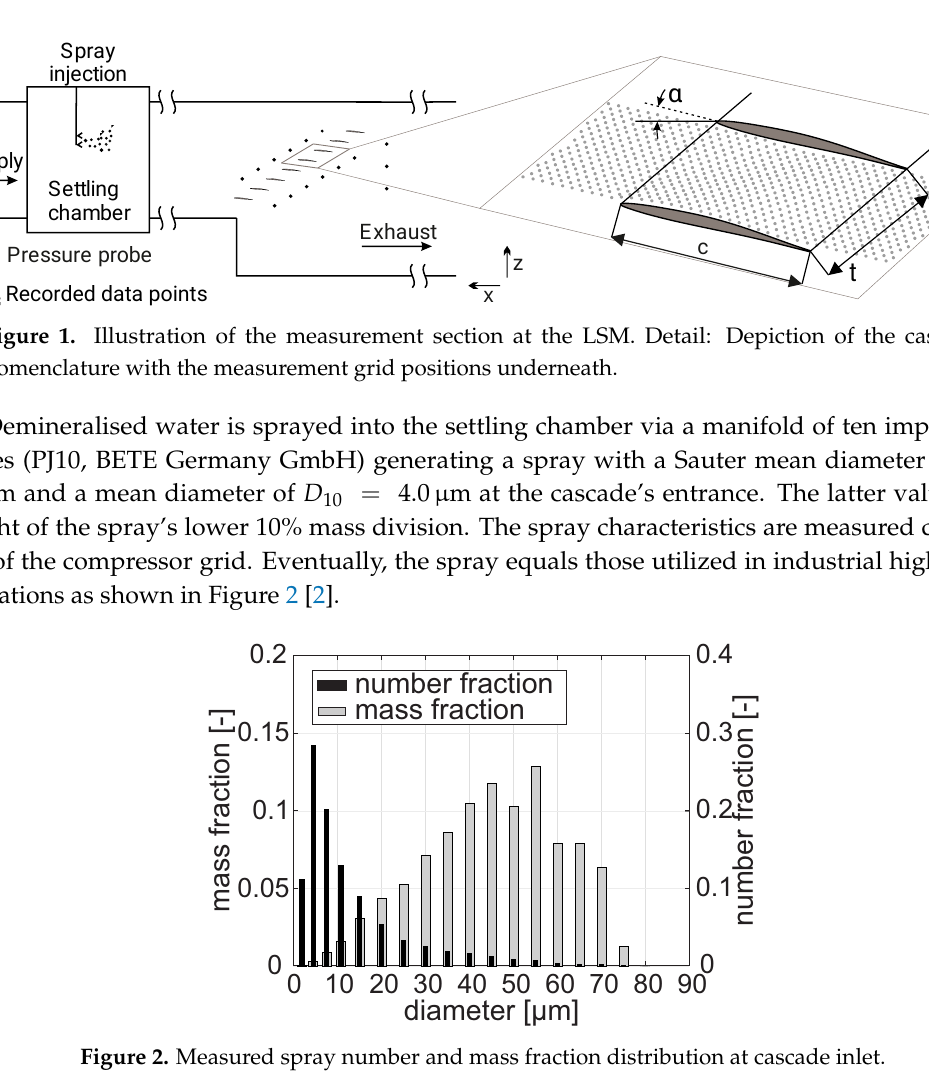
Figure 2. Measured spray number and mass fraction distribution at cascade